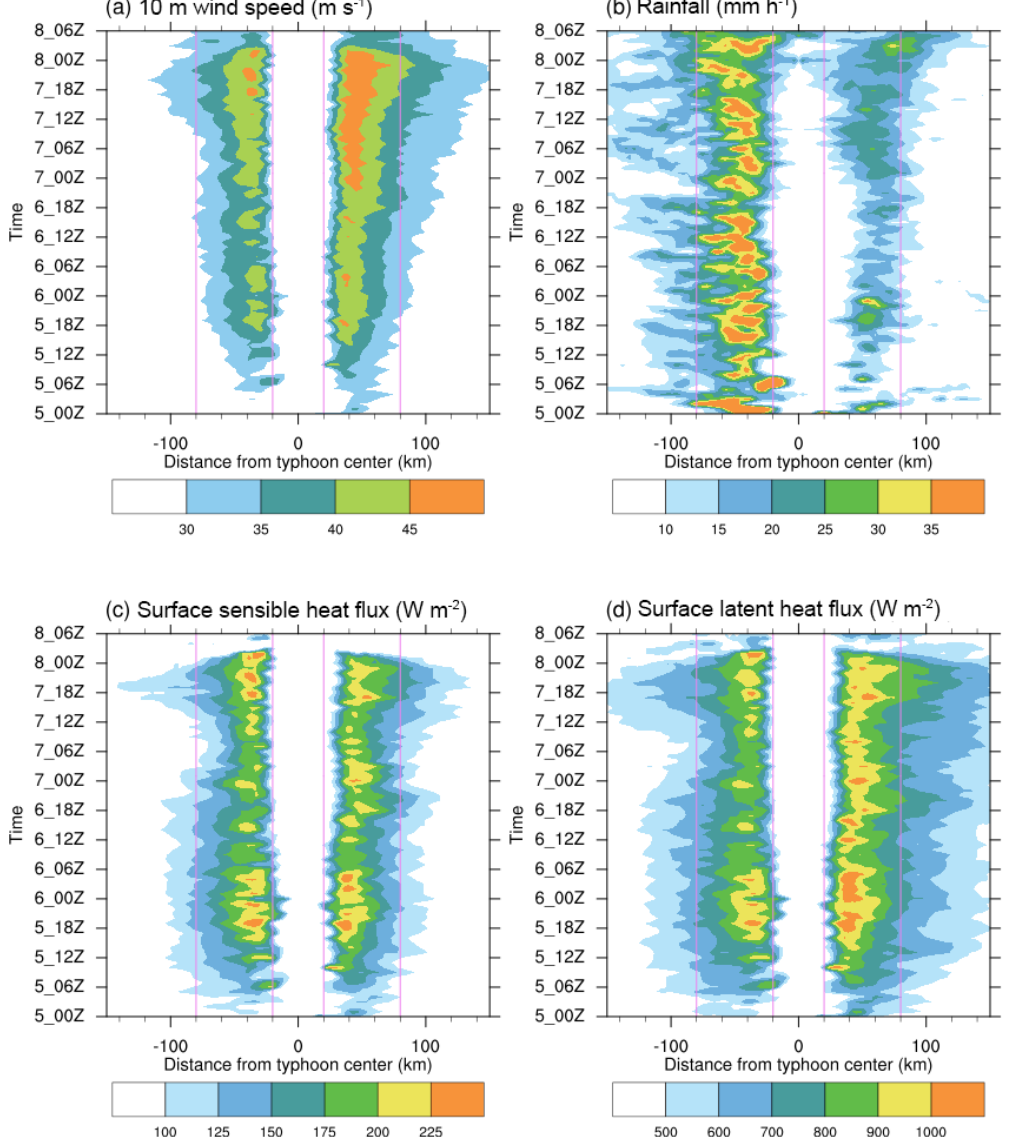
Figure 7. Radius–time cross sections of (a) 10m wind speed (ms − 1 ), (b) rainfall (mmh − 1 ), (c) surface sensible heat flux (Wm − 2 ), and (d) surface latent heat flux (Wm − 2 ) for the control experiment (3kmF0). The positive and negative distances from the typhoon center represent the azimuthal averages of the right (northern) and left (southern) semicircles, respectively, along the typhoon track. For each hourly output, the corresponding track in 3h centered at that particular hour is used to identify the semicircles on both